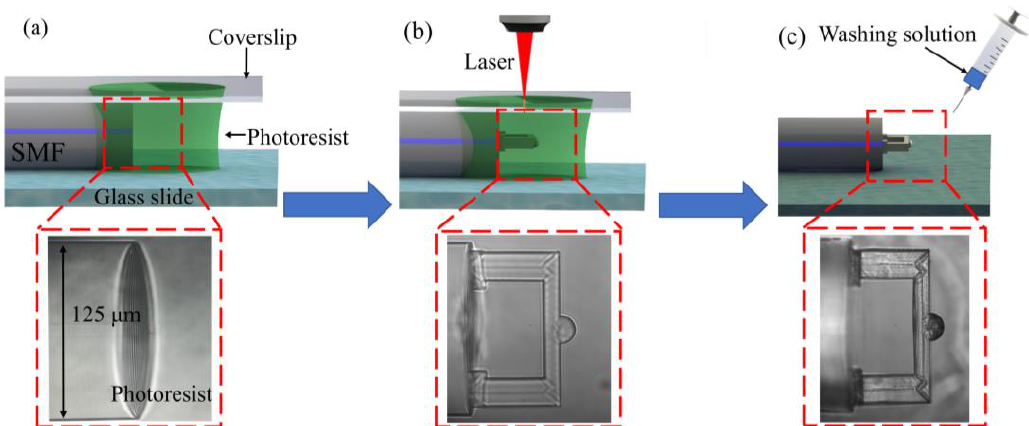
Figure 2. Process flow of fabricating the fiber-tip fixed-supported micro-bridge. ( a ) The fiber end face was cut to flat and immersed in the photoresist. A cover glass was set above the photoresist. ( b ) The fixed-supported bridge was printed on the end face of the optical fiber using TPP technology. ( c ) The cleaning solution was applied to wash off the remaining photoresist.